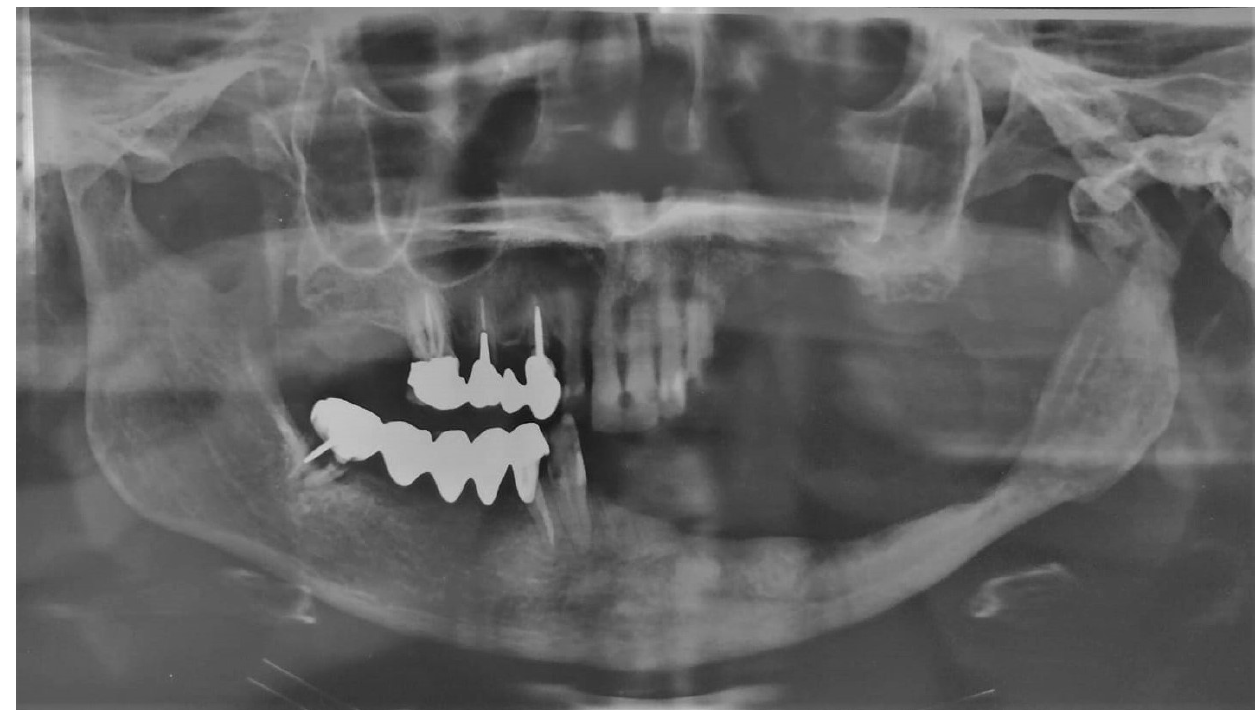
Figure 2. Group A patient. Radiological pre-operative assessment through cone beam computed tomography of a stage 2 maxillary and mandibular MRONJ. Maxillary view ( A ) and 3D reconstruction ( B ); mandibular view ( C ) and 3D reconstruction ( D ).